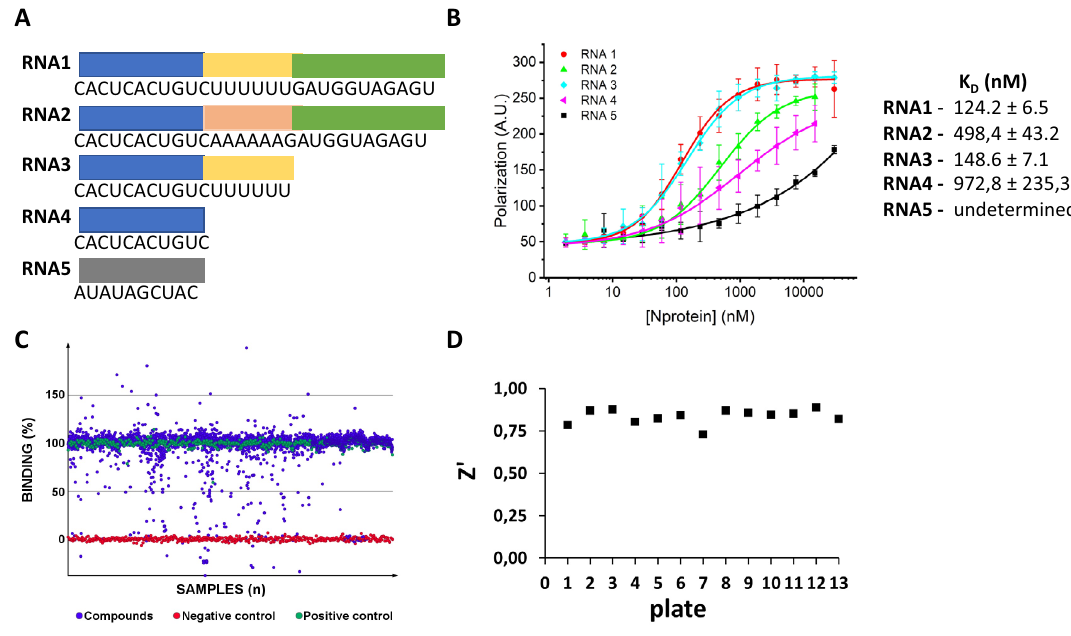
Figure 1. Development of a biochemical assay for the identification of compounds that disrupt the SARS- CoV-2 N protein-RNA interaction. ( A ) Nucleotide sequences of the RNA molecules used as N-protein ligands. The blue, yellow and green regions represent the 3’ arm, the UUU UUU motif and the 5’ arm, respectively. ( B ) FP assay showing the binding affinity curves of the N protein with the FITC-labelled RNA probes 1 to 5 and the corresponding binding equilibrium constants (K D ) determined by FP. High-affinity binding was observed with RNAs 1 and 3 derived from the putative SARS-CoV-2 PS sequence. The mutated RNA sequences 2 and 4, and RNA5, used as a negative control, show, in comparison, much lower binding affinities. Error bars represent standard deviation of the means from triplicate experiments. ( C ) Scatterplot of HTS results showing the binding percentage of each compound in the library calculated using polarization data from negative (RNA alone) and positive (RNA plus protein) controls. Seventy-eight compounds reduced the binding of the N protein to RNA1 to less than 30%, of which 45 were selected for concentration-dependent assays. Compounds that would promote RNA-N complex formation (activators, binding > 100%) were not further considered. ( D ) Z’ values obtained for each assay plate confirming the robustness of the HTS